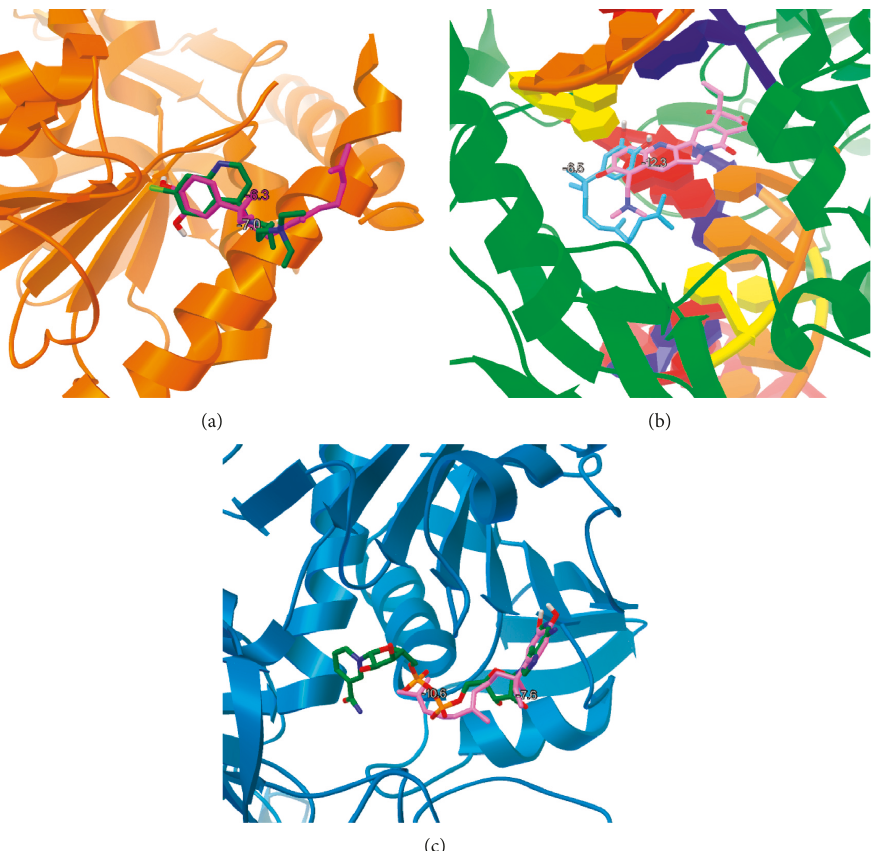
Figure 8: Superimpositions of the docked 4NRC structures and cocrystallized ligands into the selected enzymes, PfLDH, TOPO I, and GAPDH. (a) Comparison of the docked 4NRC (magenta) and cocrystallized structure of chloroquine (green); (b) comparison of the docked 4NRC (blue) and cocrystallized structure of topotecan (pink); (c) comparison of the docked 4NRC (pink) and cocrystallized structure of NADH